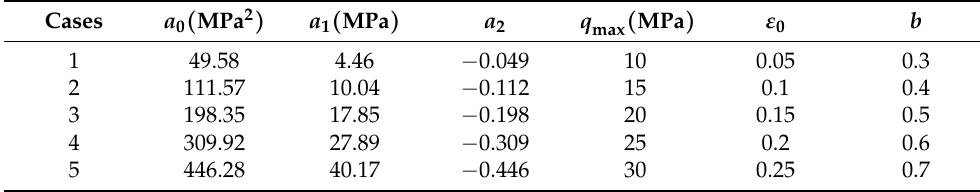
Table 8. Values of a i ( i = 0,1,2 ) , q max , ε 0 , and b